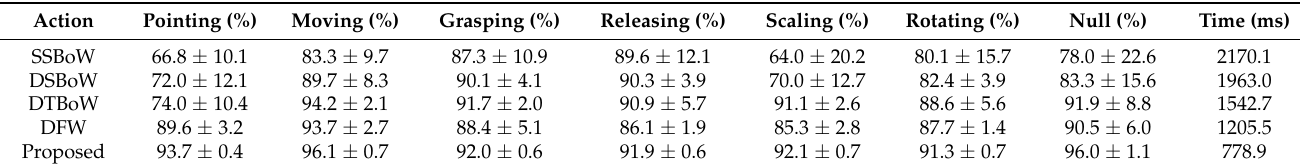
Table 6. The recognition accuracy and processing time on HoloLens ARAAT Dataset with other algorithms.